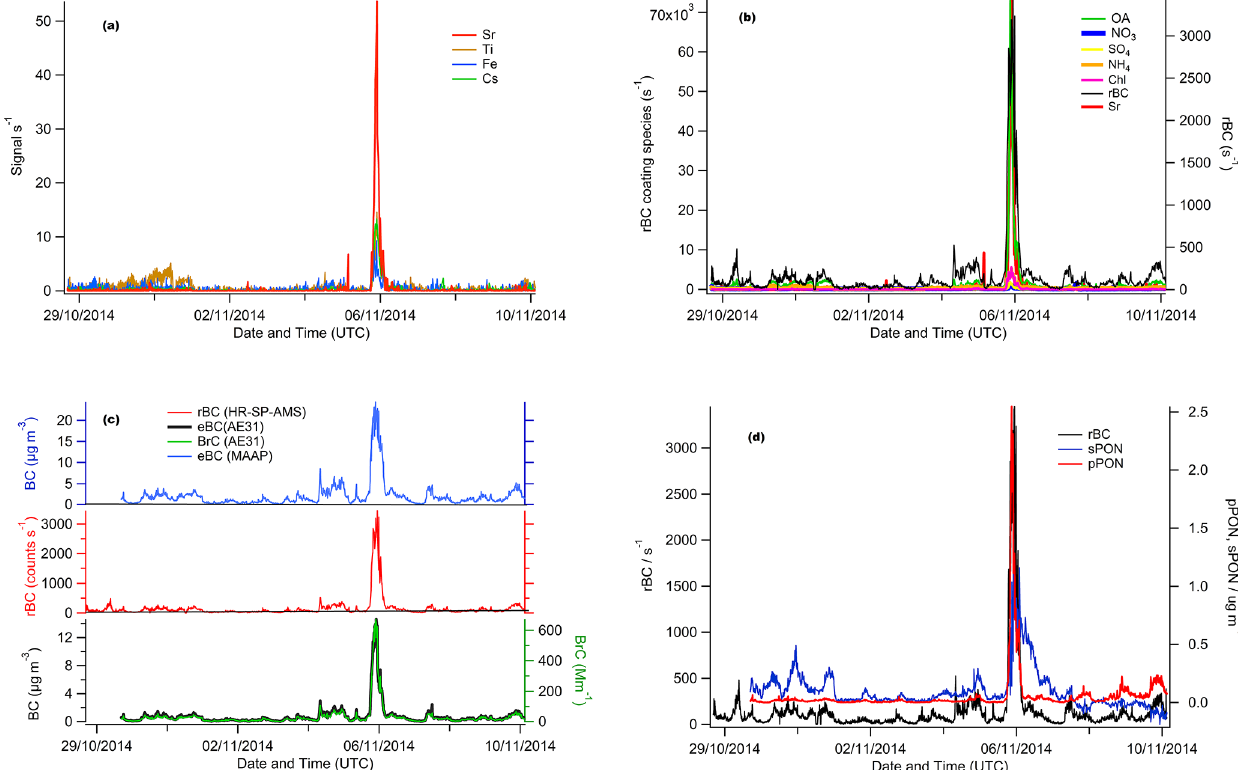
Figure 2. Time series of different variables observed during the bonfire event. (a) Time series of various metal pollutant concentrations; (b) time series of high-resolution rBC concentrations and its coating species (organics and inorganics); (c) time series of black carbon measured by different instruments, i.e HR SP-AMS (rBC), AE31 (eBC and BrC), and MAAP (eBC); (d) time series of rBC and primary (pPON) and secondary (sPON) organic